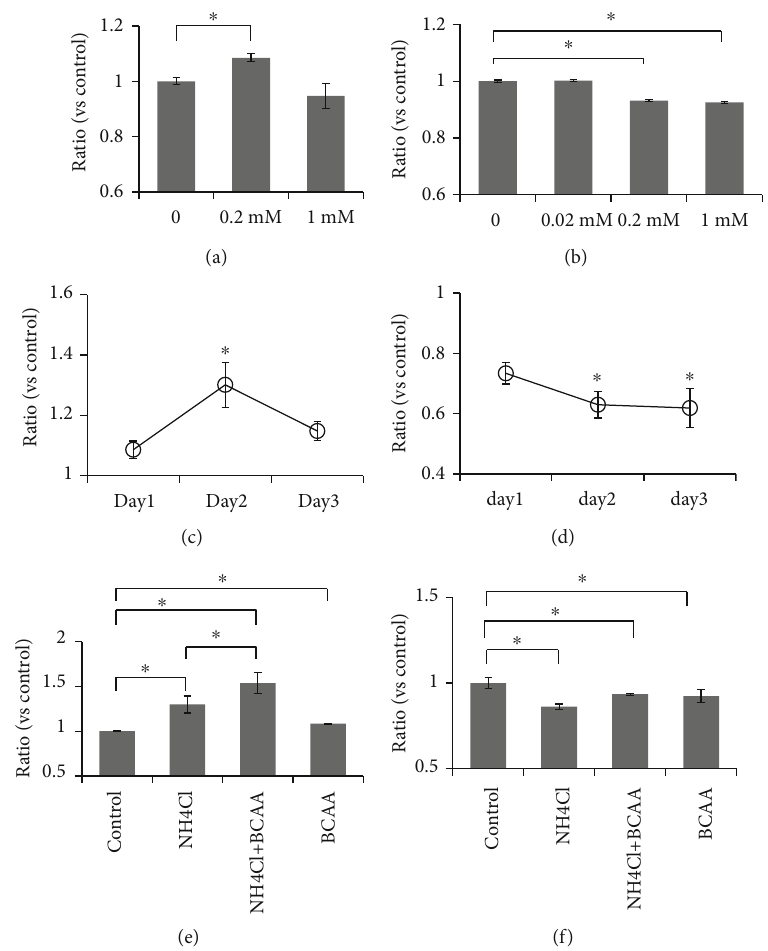
Figure 1: BCAA induce cytotoxicity and reduce astrocyte viability. LDH cytotoxicity assay (a) and evaluation of viable cells (b) among astrocytes following treatment with 0-1mM BCAA. HT22 cells (c) and HepG2 cells (d) were treated with 0.2mM BCAA for 24, 48, and 72h prior to calculating cell viability. LDH cytotoxicity assay (e) and evaluation of viable cells (f) among astrocytes, following treatment with 0.2mM BCAA, 10 mM NH Cl, and BCAA+NH Cl cotreatments. Control: no treatment with either BCAA or other reagents. Data 4 4 are presented as the mean ± SD ; n = 3 ; ∗ p < 0 : 05